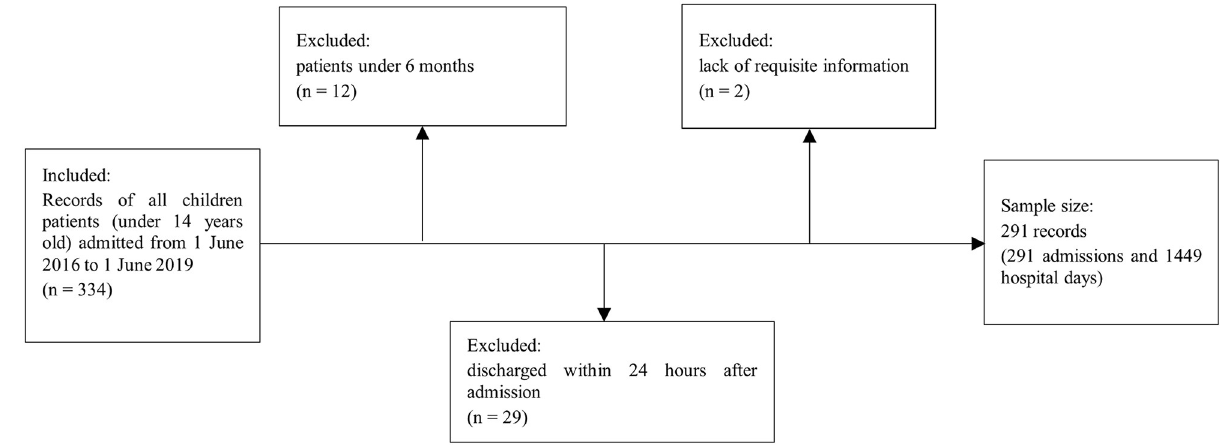
Fig 1. Identification for inclusion and exclusion of